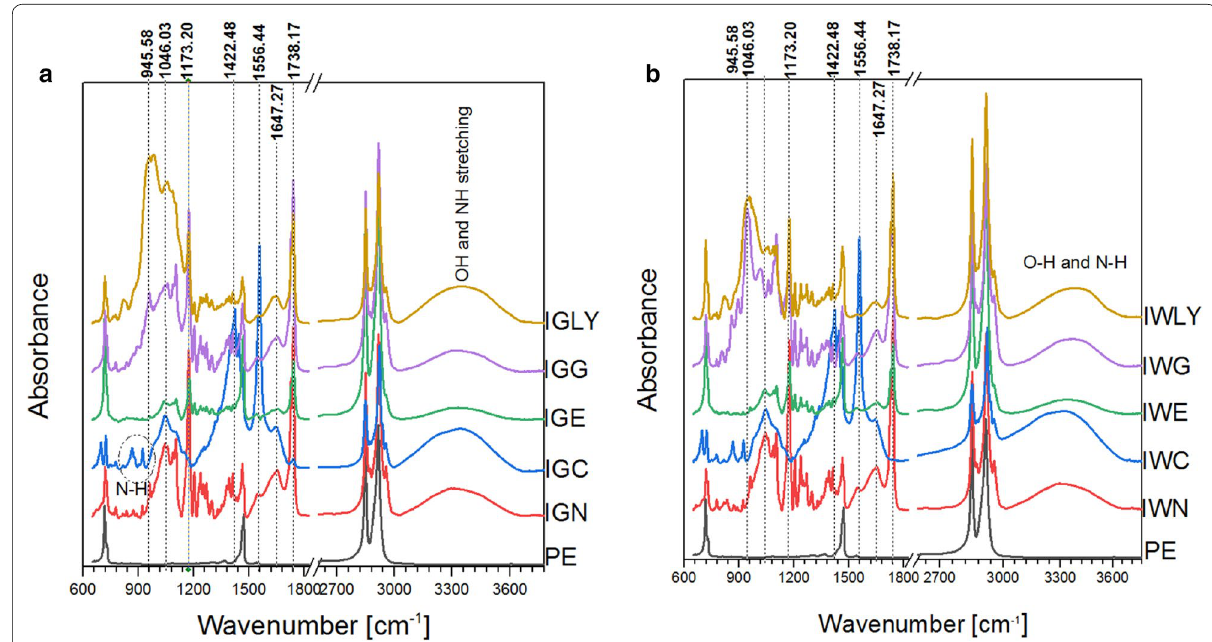
Fig. 2 Fourier transform infrared spectroscopy (FTIR) spectra of Irvingia‑based adhesives and PE (O–H